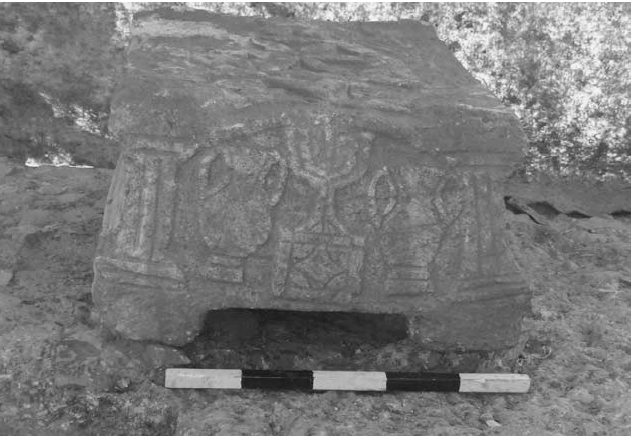
Figure 1. Façade Panel, featuring a menorah flanked by two amphorae. Image used with permission.